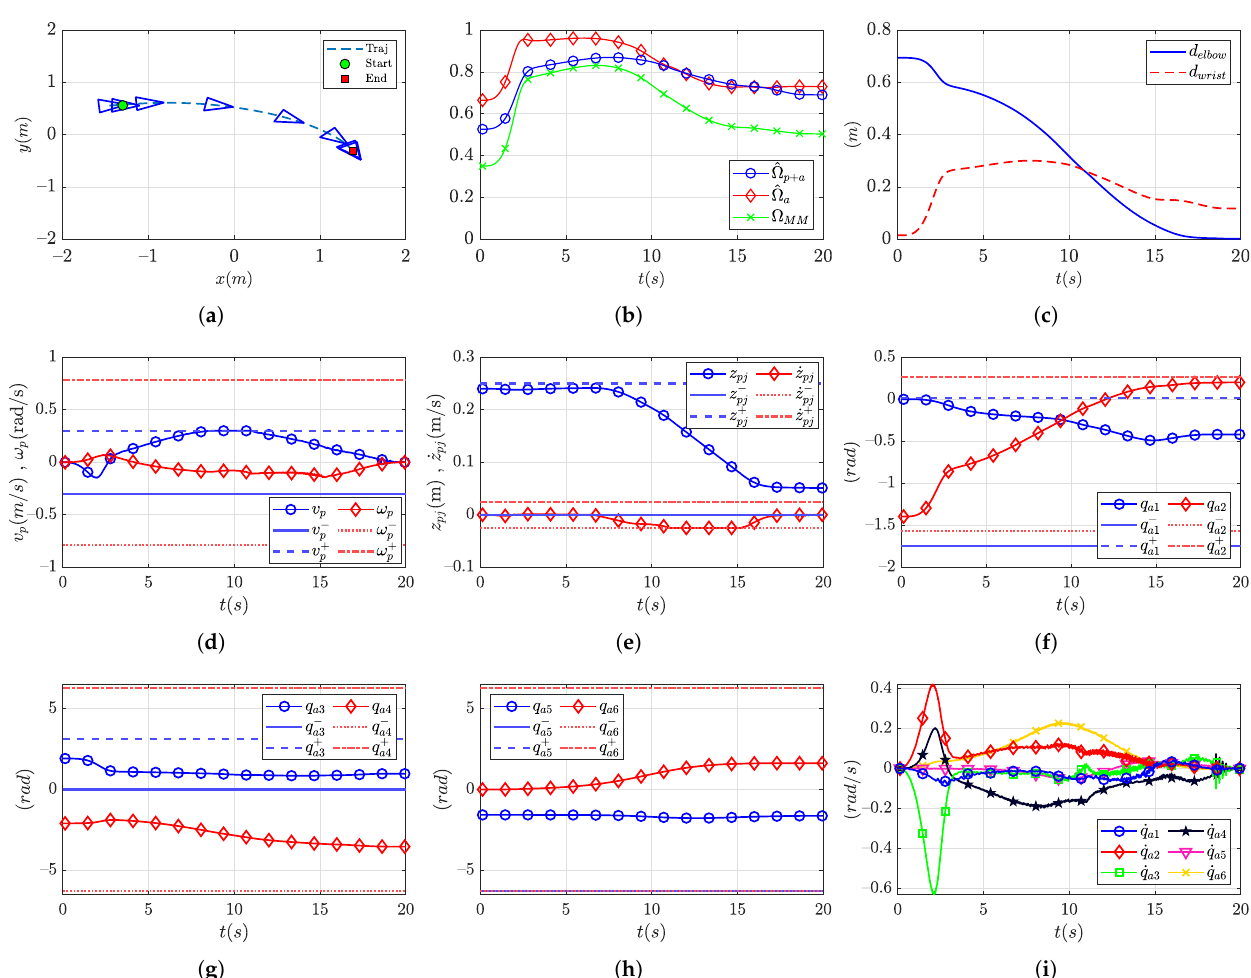
Figure 12. Experiment results for the elliptic trajectory tracking: ( a ) mobile platform’s trajectory; ( b ) normalized manipulabil- ity measures; ( c ) self-collision distance; ( d ) mobile platform’s velocity commands; ( e ) prismatic joint’s position and velocity; ( f – h ) arm’s joint positions; ( i ) arm’s joint velocities. Notice that all the joint limits and velocity limits are respected (panels ( d – i )). The potential self-collisions described in Section 5.2 are prevented (panel ( c )). Furthermore, the manipulabilities of both the arm and the whole system are improved (panel ( b )). See Section 5.5 for a detailed discussion of this